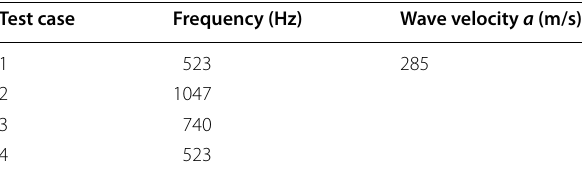
Table 3 Predicted frequency of geometry resonance modes